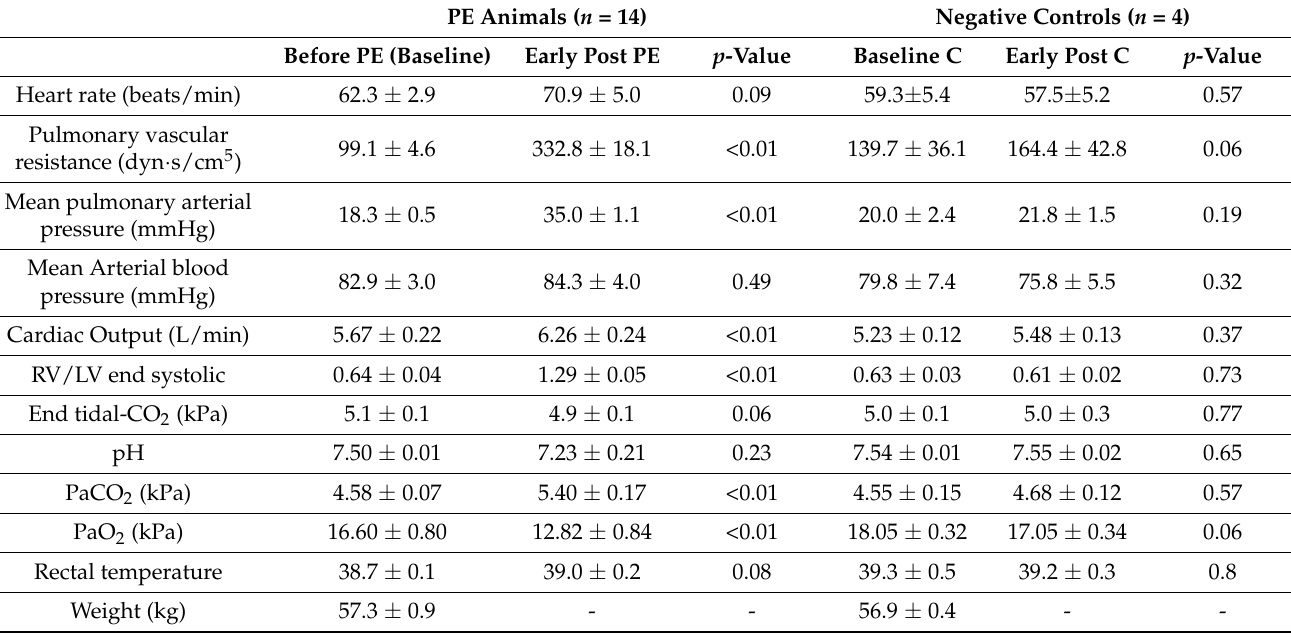
Table 1. Clinical data, functional and invasive measures at baseline and 30 min after pulmonary embolism for PE animals and at index times for the negative controls. (mean ± SEM). PE Animals ( n = 14) Negative Controls ( n = 4) Before PE (Baseline) Early Post PE p -Value Baseline C Early Post